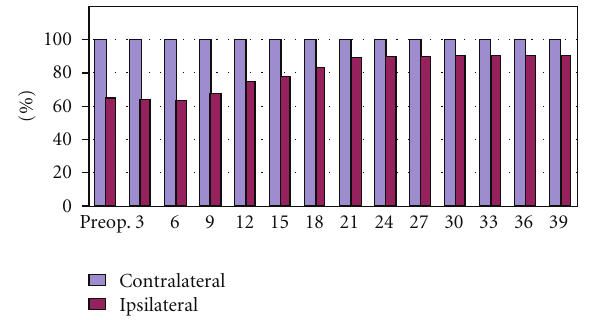
Figure 2: Bilateral testis volumes in control intervals (mean con- tralateral testicular volume was admitted as 100 units).